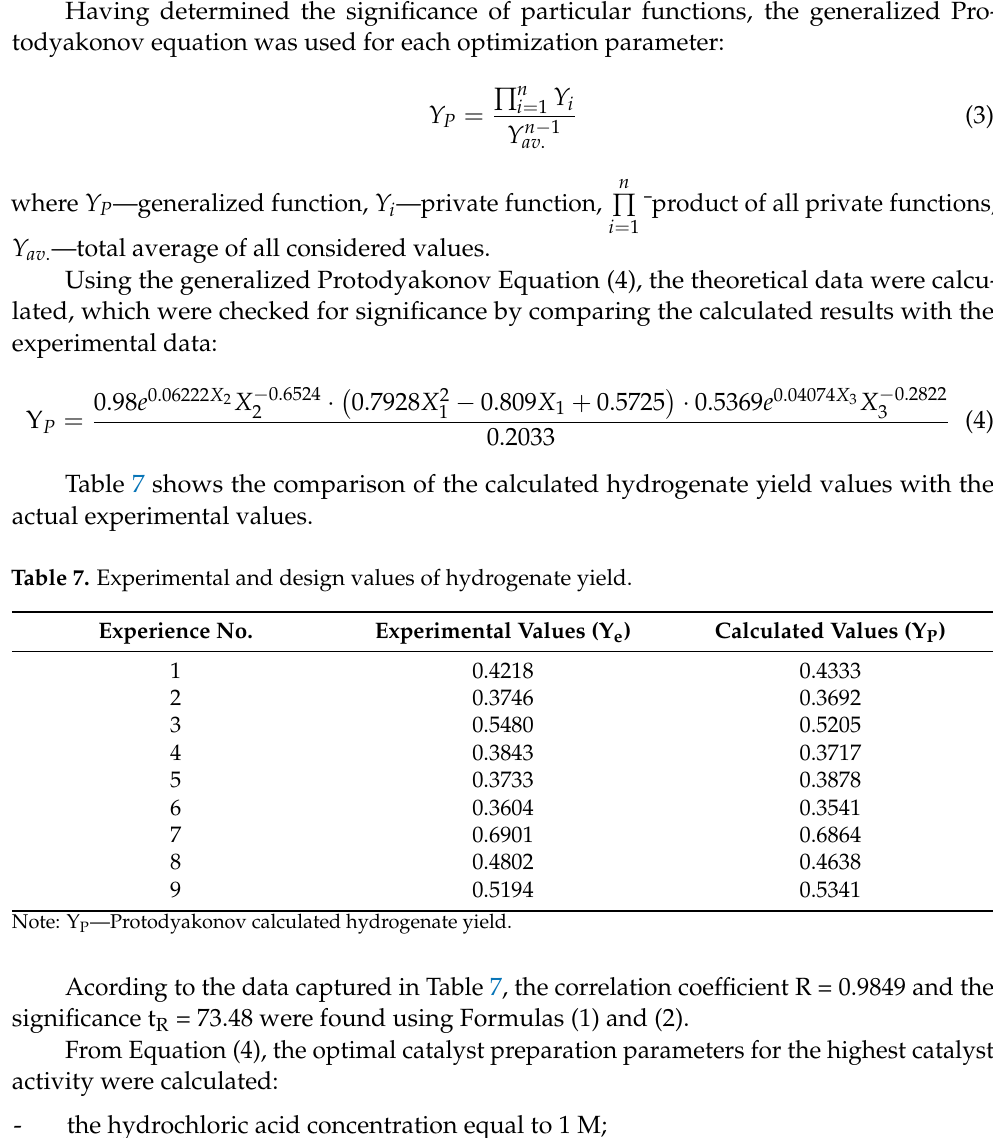
Table 6. Calculated values of the partial functions for Y P . Function